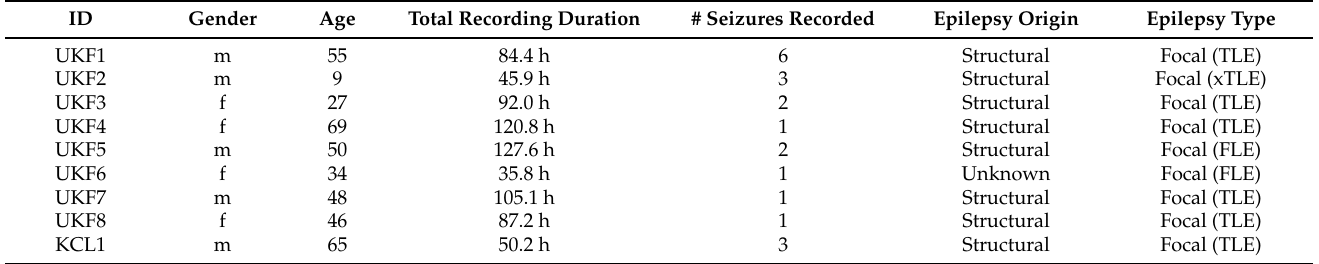
Table A2. Demographic and clinical information for the nine selected participants. TLE: temporal lobe epilepsy; FLE: frontal lobe epilepsy; xTLE: extratemporal lobe epilepsy.